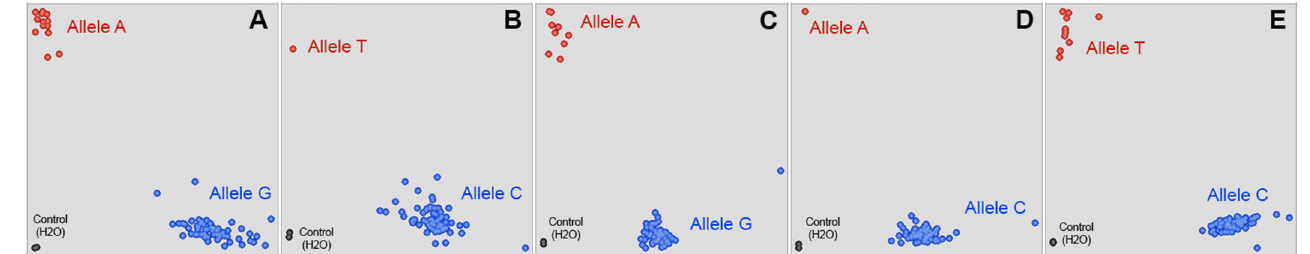
Figure 6. KASP plots of five SNPs associated with grain quality traits. ( A ) ipbb_hv_6 . ( B ) ipbb_hv_7 . ( C ) ipbb_hv_116. ( D ) ipbb_hv_119 . ( E ) ipbb_hv_128 . Red and blue dots denote genotypes and black dots are negative control (H 2 O).